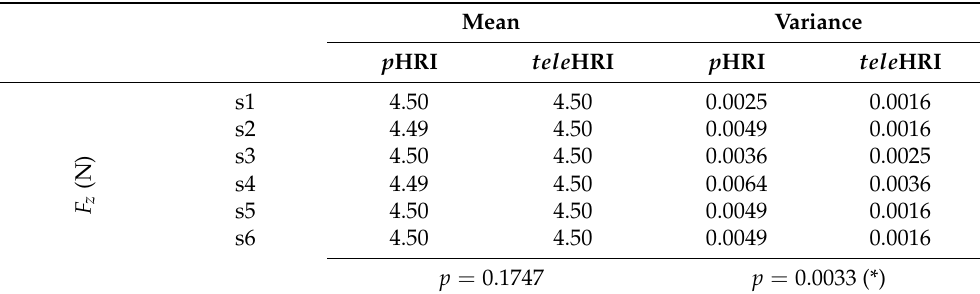
Table A5. Comparing the general performance of the proposed dual-mode p HRI- tele HRI system when mode switching is involved in Experiment 3.